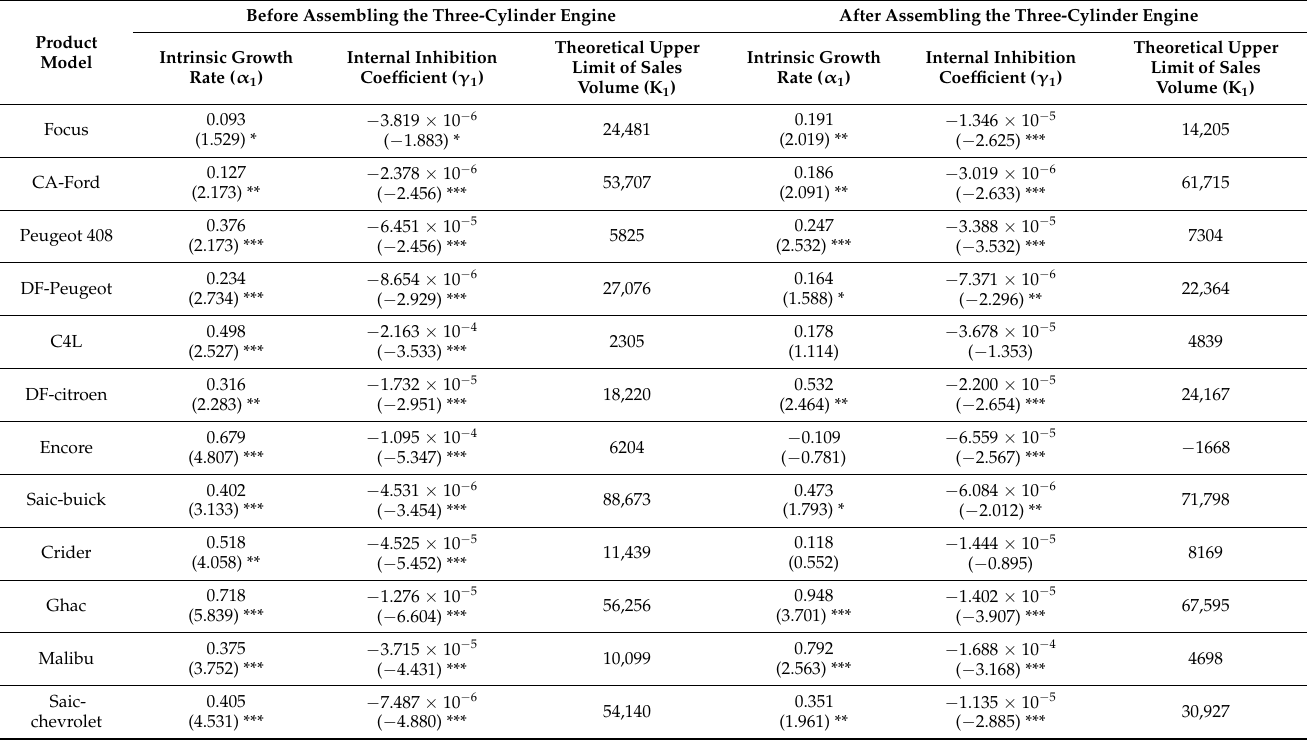
Table 2. Logistic model results of vehicle models and enterprise